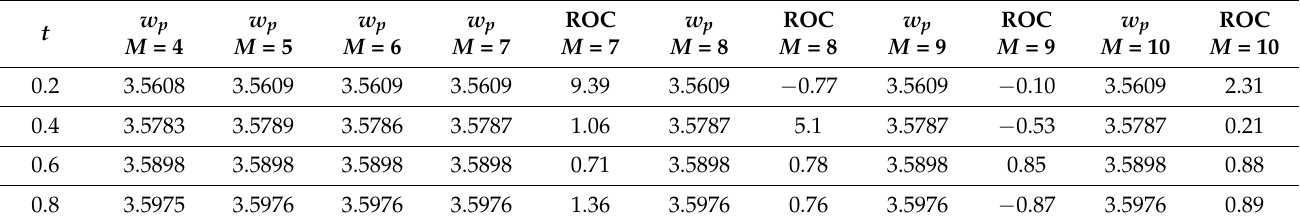
Table 7. The values of w p and rate of convergence (ROC) at different points for k = 2 and various values of M by Bernoulli